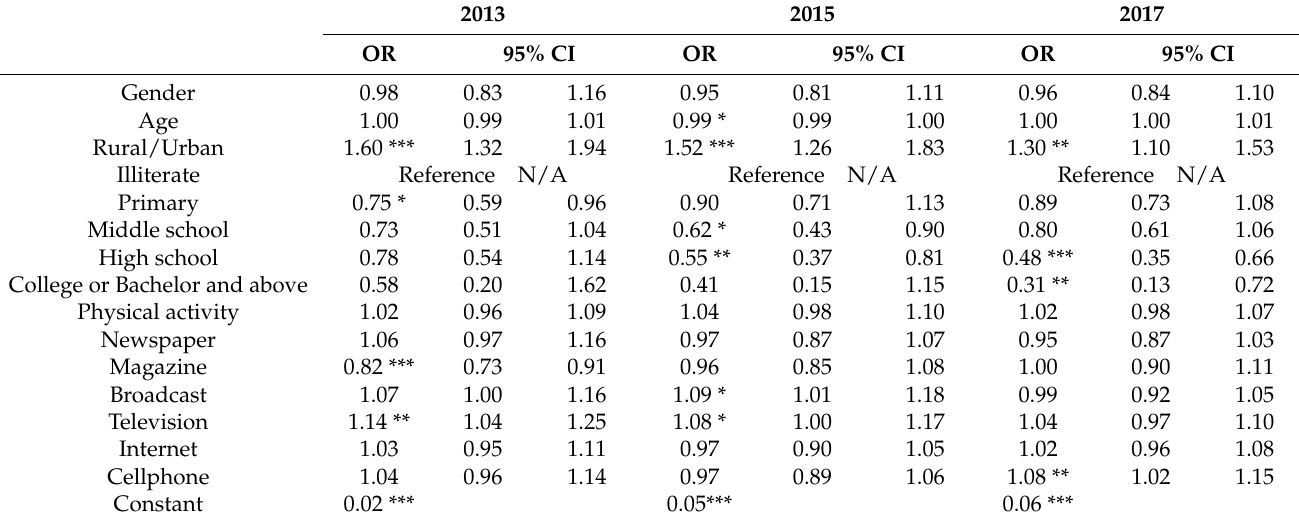
Table 2. Logistic regression analysis of associations between media use and obesity in 2013, 2015, and